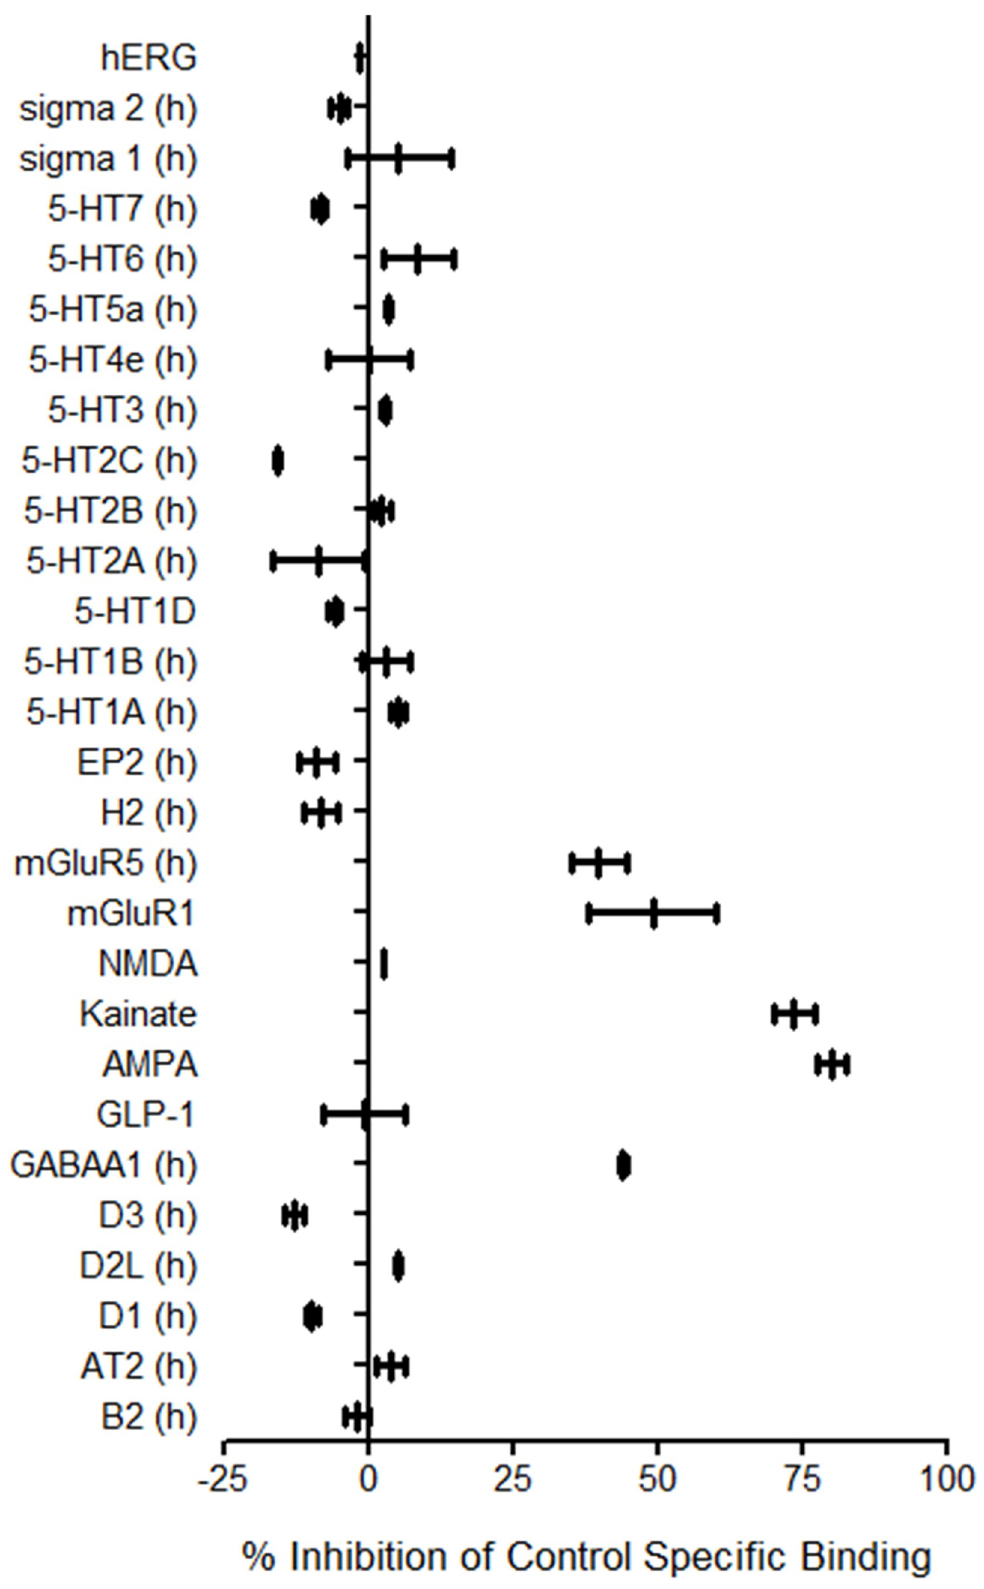
Fig 14. Cortexin 1 receptor binding in vitro . Data shown as the median and range (n = 2). https://doi.org/10.1371/journal.pone.0254493.g014 PLOS ONE | https://doi.org/10.1371/journal.pone.0254493 July 14,